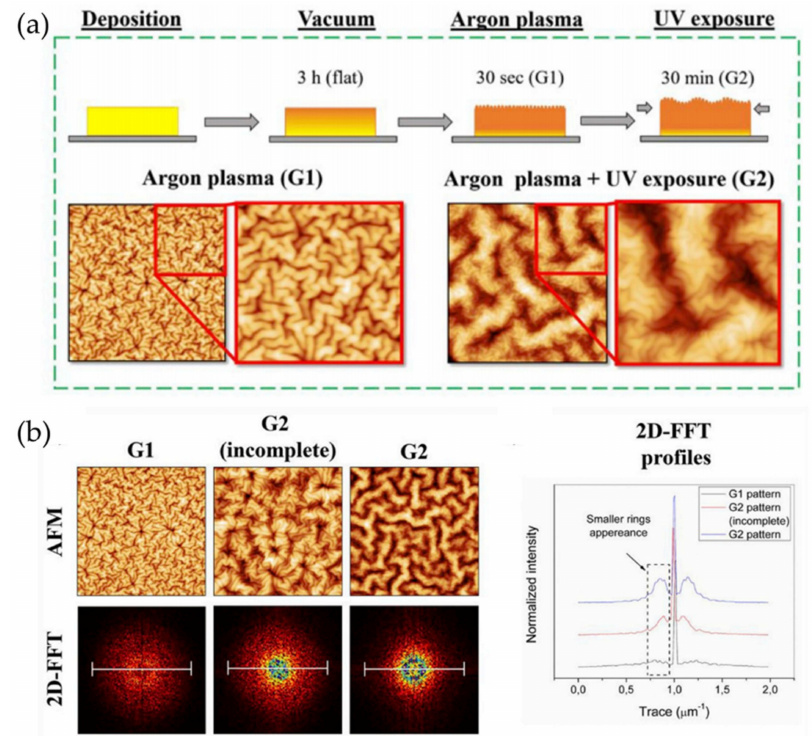
Figure 35. ( a ) Schematic illustration of the methodology used to fabricate hierarchically structured wrinkled hydrogel films, together with AFM micrographs for each sample 15:1 net-poly(DMAEMA- co -PEGDA 575 ) and ( b ) AFM micrographs of G1, incomplete G2 and fully formed G2 wrinkled patterns, 2D-FFT profile are depicted right. Reproduced with permission from reference [139]. Copyright 2019, Elsevier